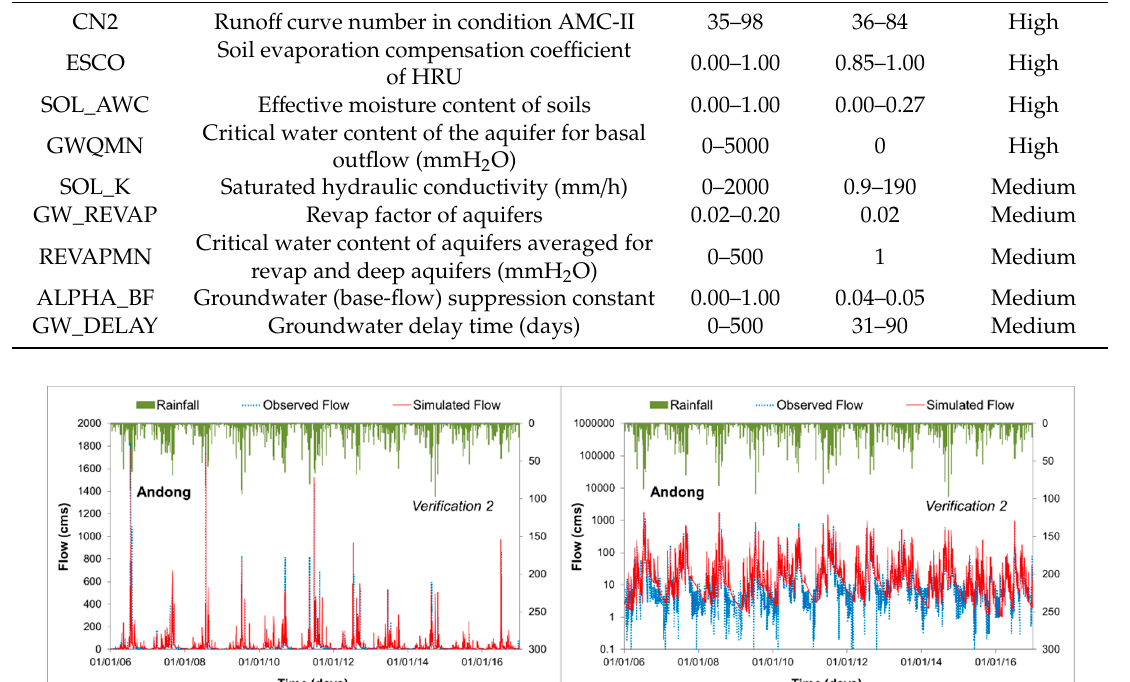
Figure 2. Comparison of streamflow simulation and observation data in the Andong dam site on a normal scale ( left ) and logarithmic scale ( right ). The green column shows the observed rainfall over the dam site, the blue dotted line shows the observed inflow discharge at the dam, and the red line shows the simulated discharge using the SWAT model.